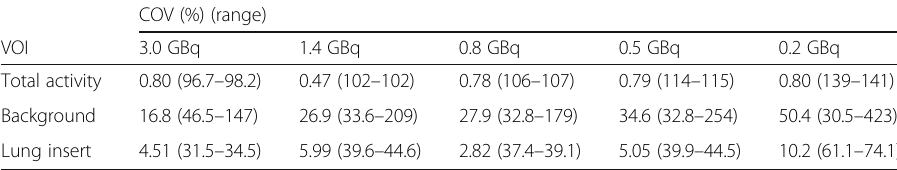
Table 5 Intra-center coefficient of variation (COV) between three consecutive scans of recovery coefficients (RCs) of total activity and background activity concentration and of counts in the cold lung insert ( C i ) on each imaging day